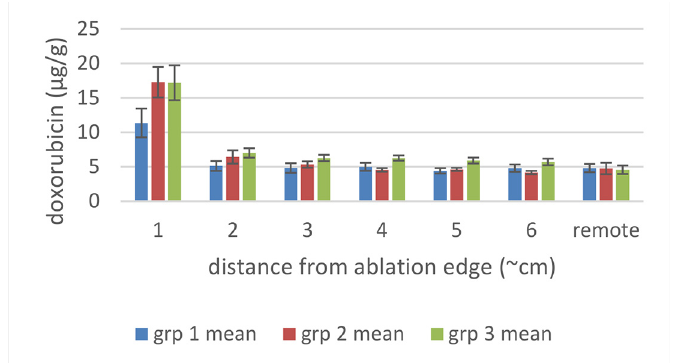
Fig 2. Mean ( ± SEM) doxorubicin tissue concentrations around the ablation zones of pigs in Study B. Punch biopsies were collected radiating out from the liver ablation zone after 1 (group 1, n = 3), 3 (group 2, n = 3) or 6 (group 3, n = 3) sequential, overlapping ablations using the Covidien device. Distance 1 is just adjacent to the ablation margin and distance 6 is the furthest away from the ablation